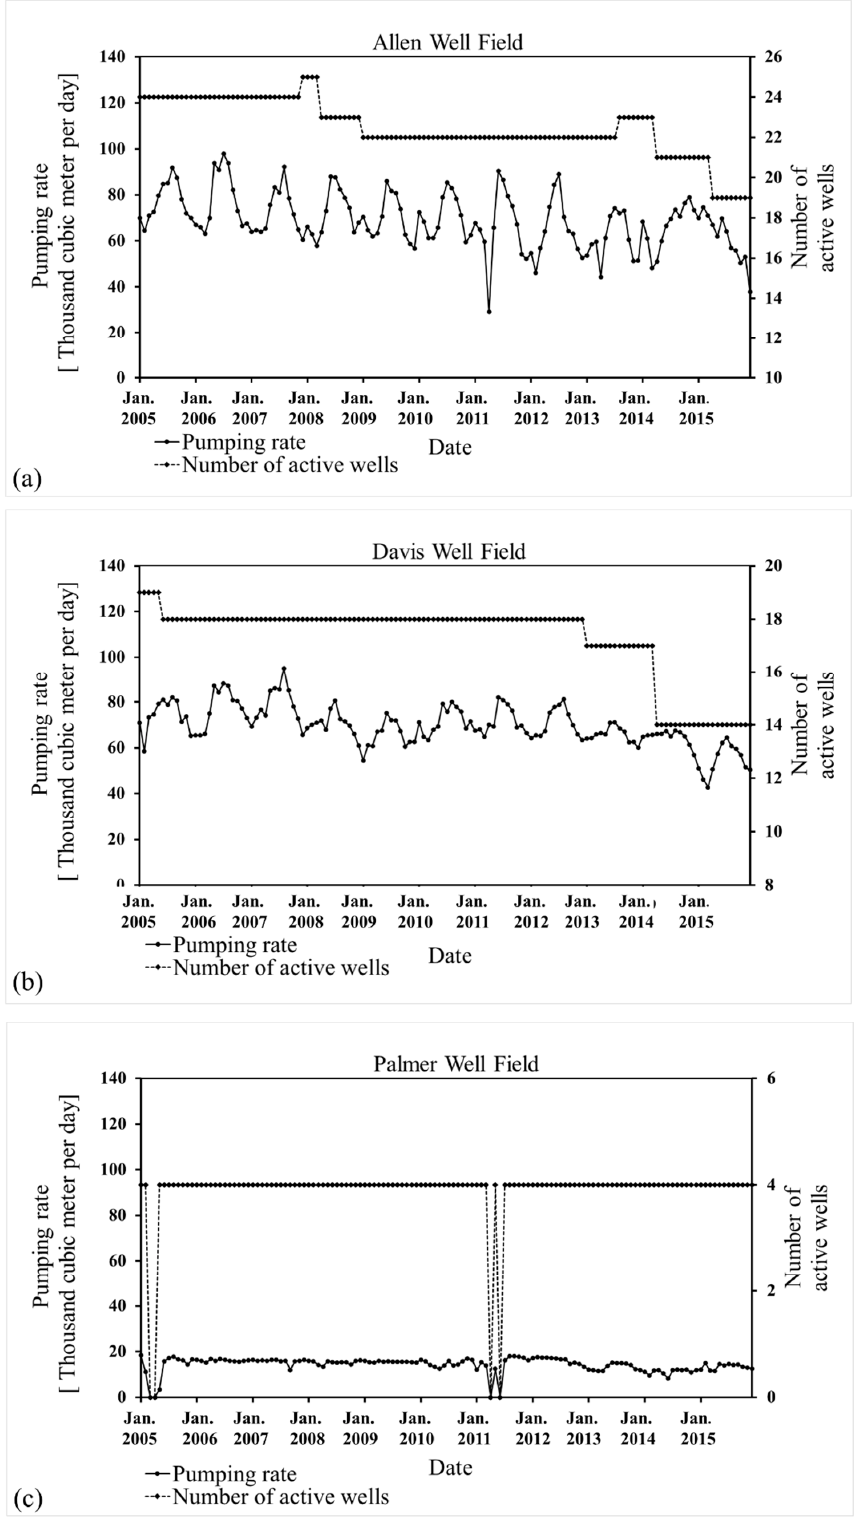
Figure 6. ( a – c ) shows the pumping rates and the number of active wells of Allen, Davis, and Palmer well fields from 2005 to 2015 in each month,